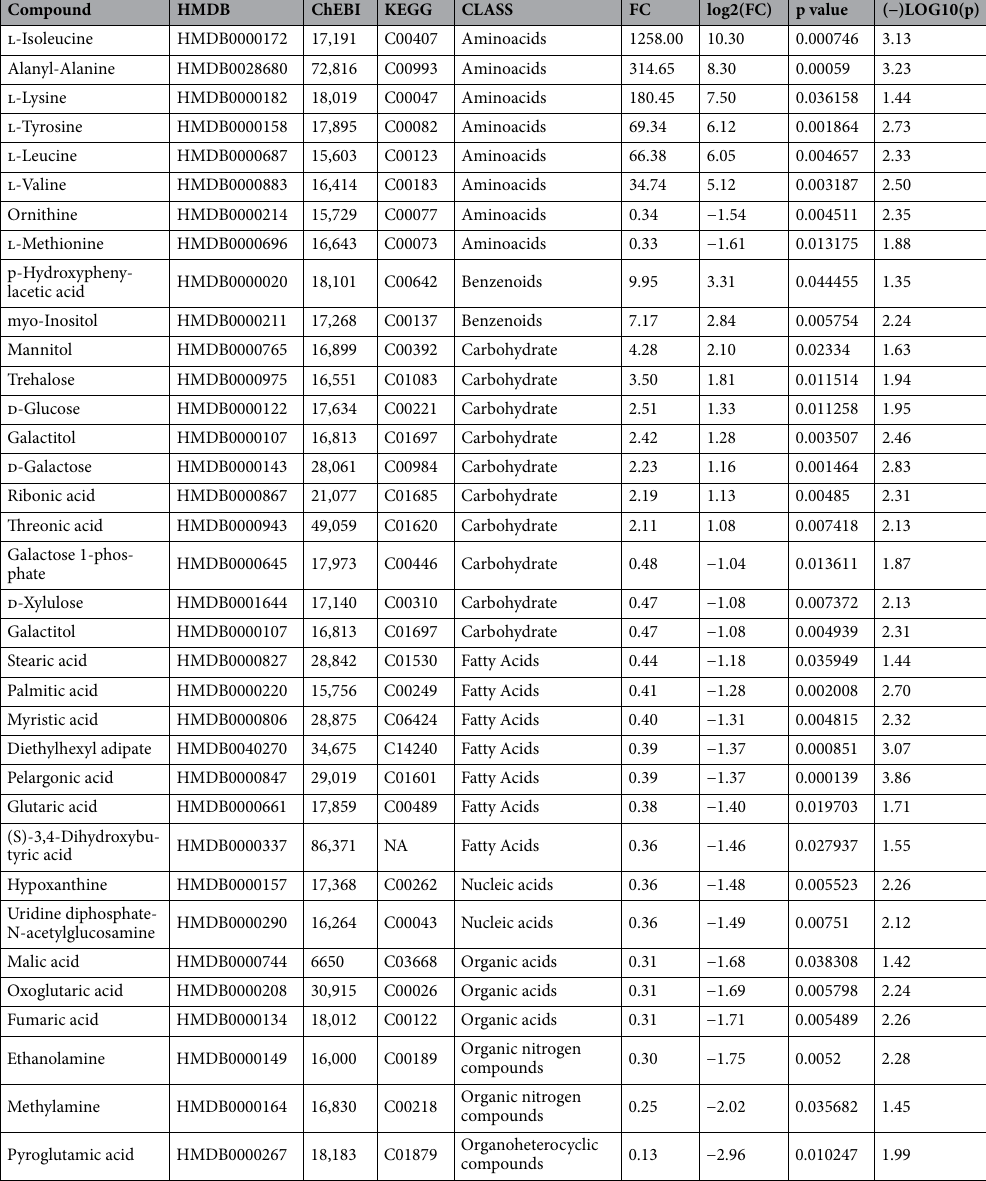
Table 1. List of metabolites of bFLS treated with bTNF-α. Fold of change (FC) described are the ratio of bTNF-α/vehicle. The class, FC, log2(FC), p value, and (−)LOG10(p) were obtained from MetaboAnalyst